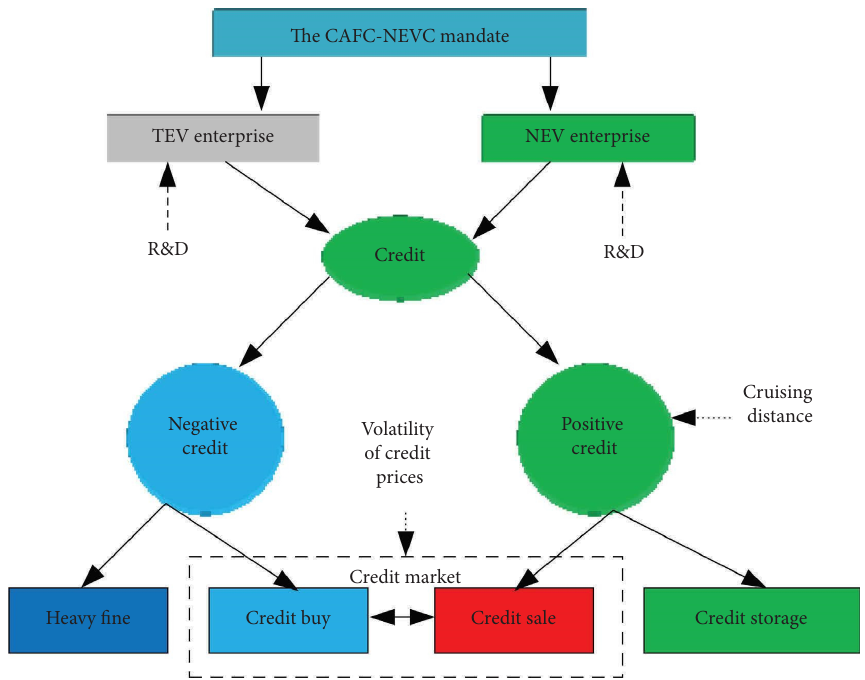
Figure 1: Conceptual framework of the CAFC-NEVC